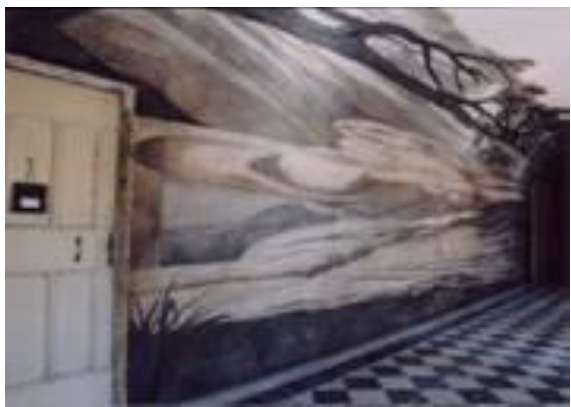
Fig. 16 Chapel of the Holy Shroud (Guarini, Turin, 1694)